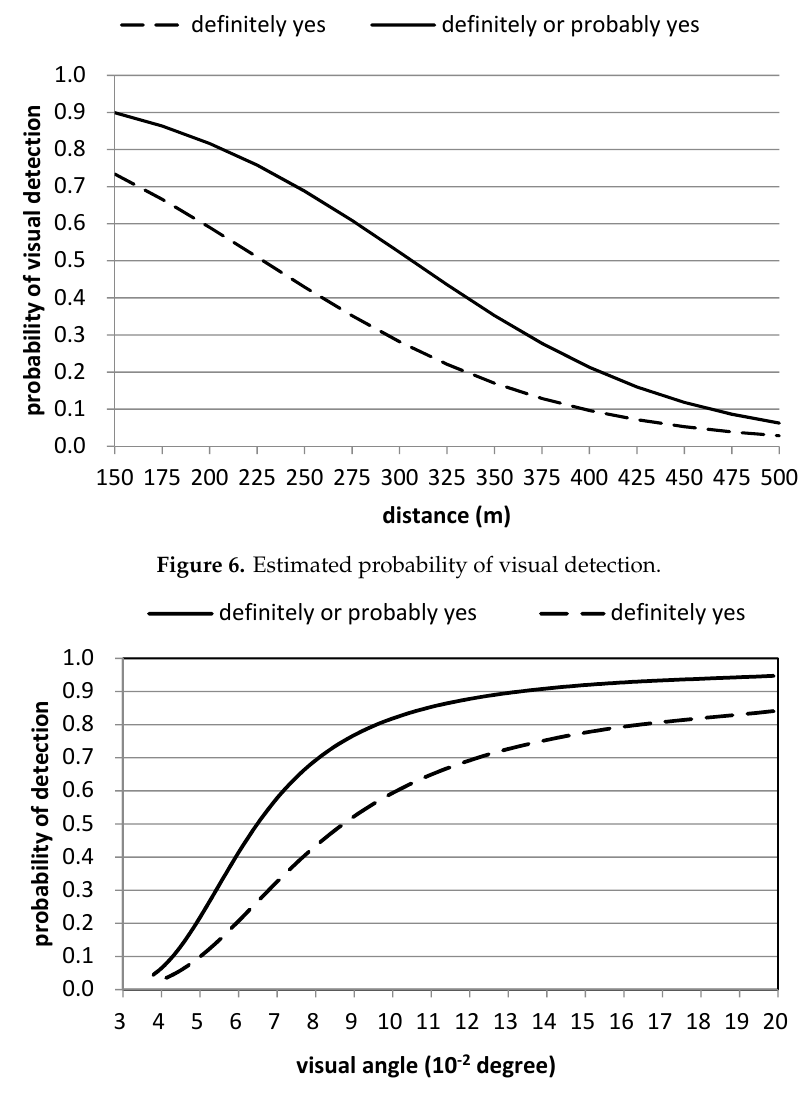
Figure 7. Probability of visual detection versus visual angle.